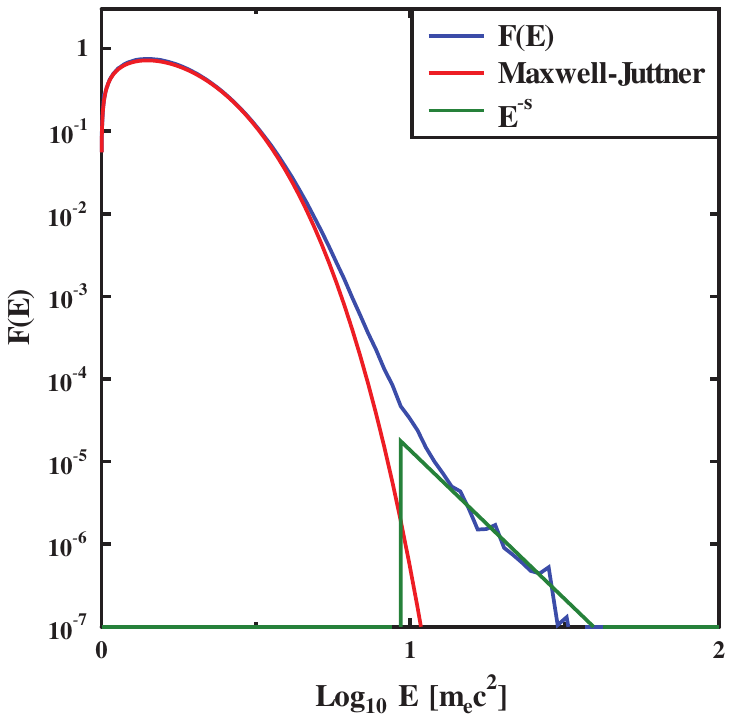
Figure 4. The electron distribution function in the shock downstream with initial parameters v = 0.3 c, σ = 2 × 10 − 4 and θ = 30 ◦ .